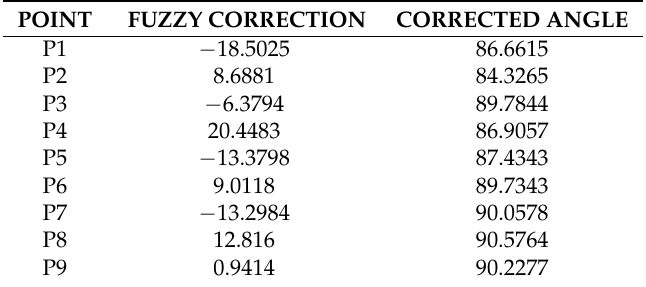
Table 2. Results obtained after having processed the information through the Fuzzy filter.